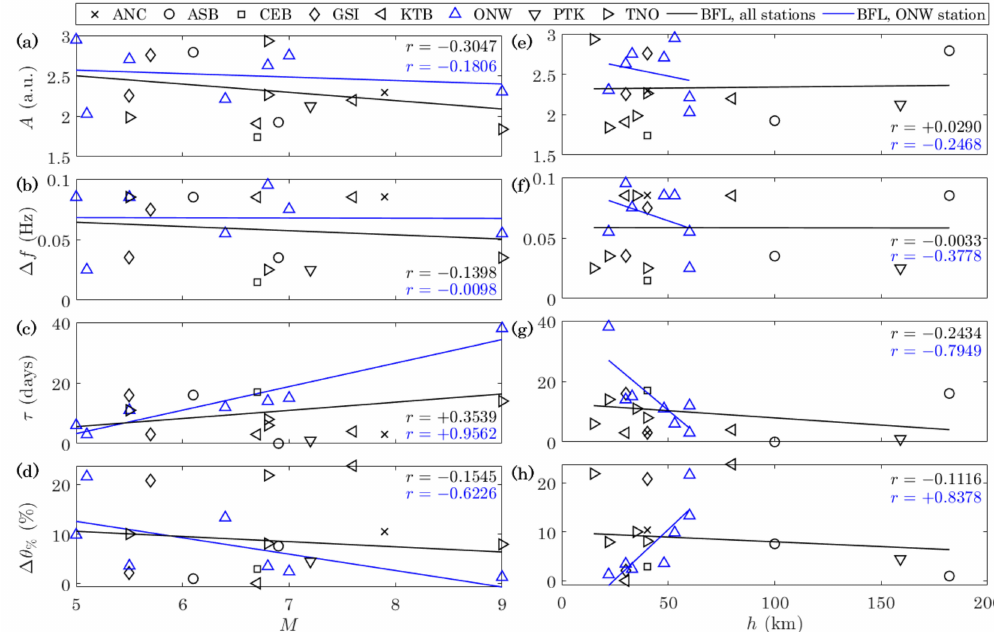
Figure 8. Scatter plots of amplitude ( A ), frequency ( ∆ f ), lead time ( τ ) and percentage of error ( ∆ ϑ % ) against magnitude ( M ) in ( a – d ), and against hypocentral depth ( h ) in ( e – h ). Straight lines show best-fit lines (BFL) using all stations (black) and only ONW station data points (blue). Corresponding r values are written in the respective colors.